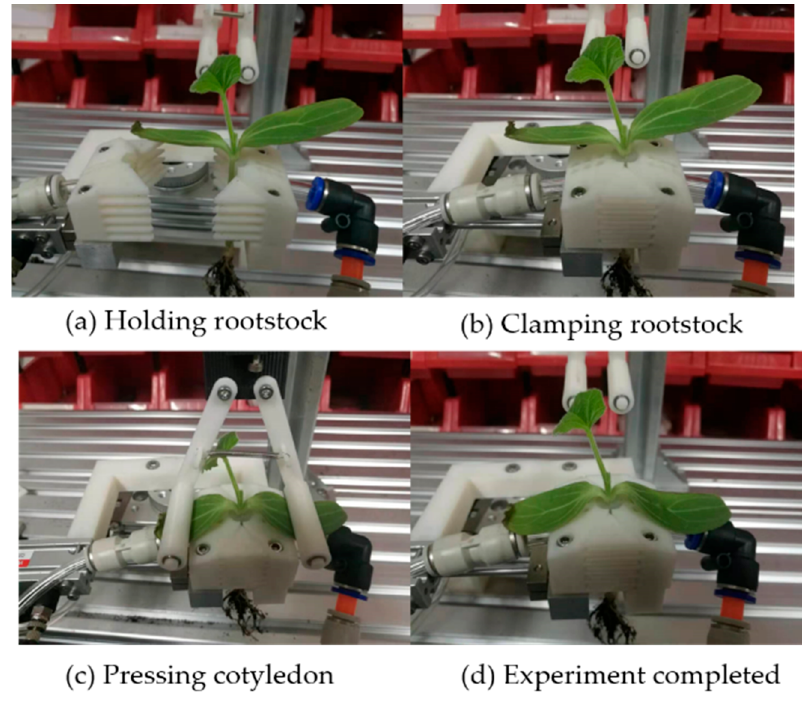
Figure 9. Diagram of rootstock holding